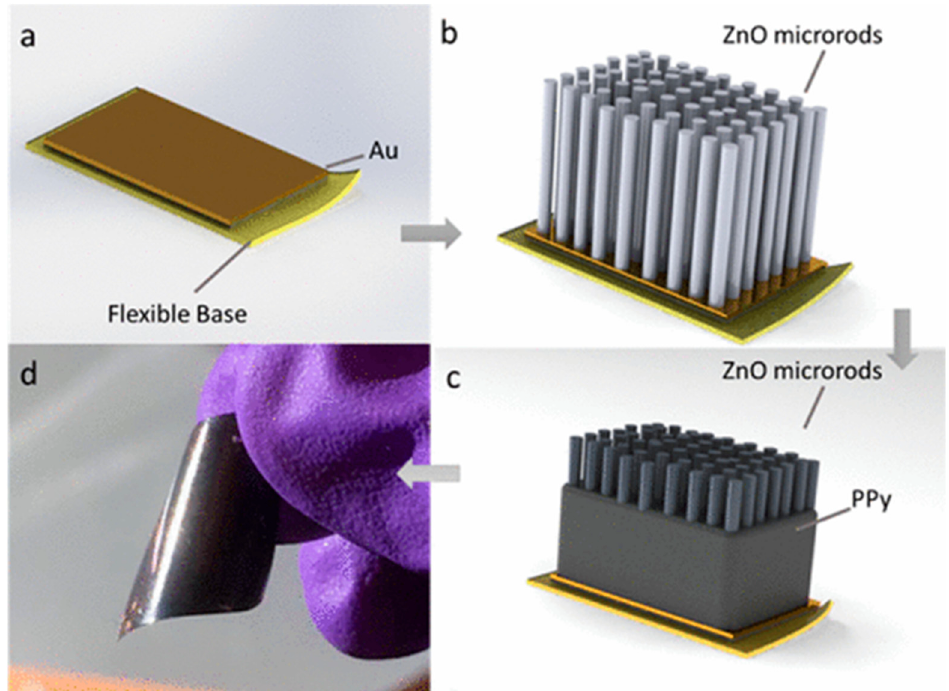
Figure 3. Schematic illustration of the preparation process of a flexible ZnO-microrod/PPy composite film. ( a ) Flexible base polyester film. ( b ) ZnO-microrod arrays were grown on the base polyester film. ( c ) PPy was electrodeposited onto the ZnO-microrod arrays. ( d ) Optical image of highly flexible ZnO-microrod/PPy composite film (20 mm × 20 mm) [33].